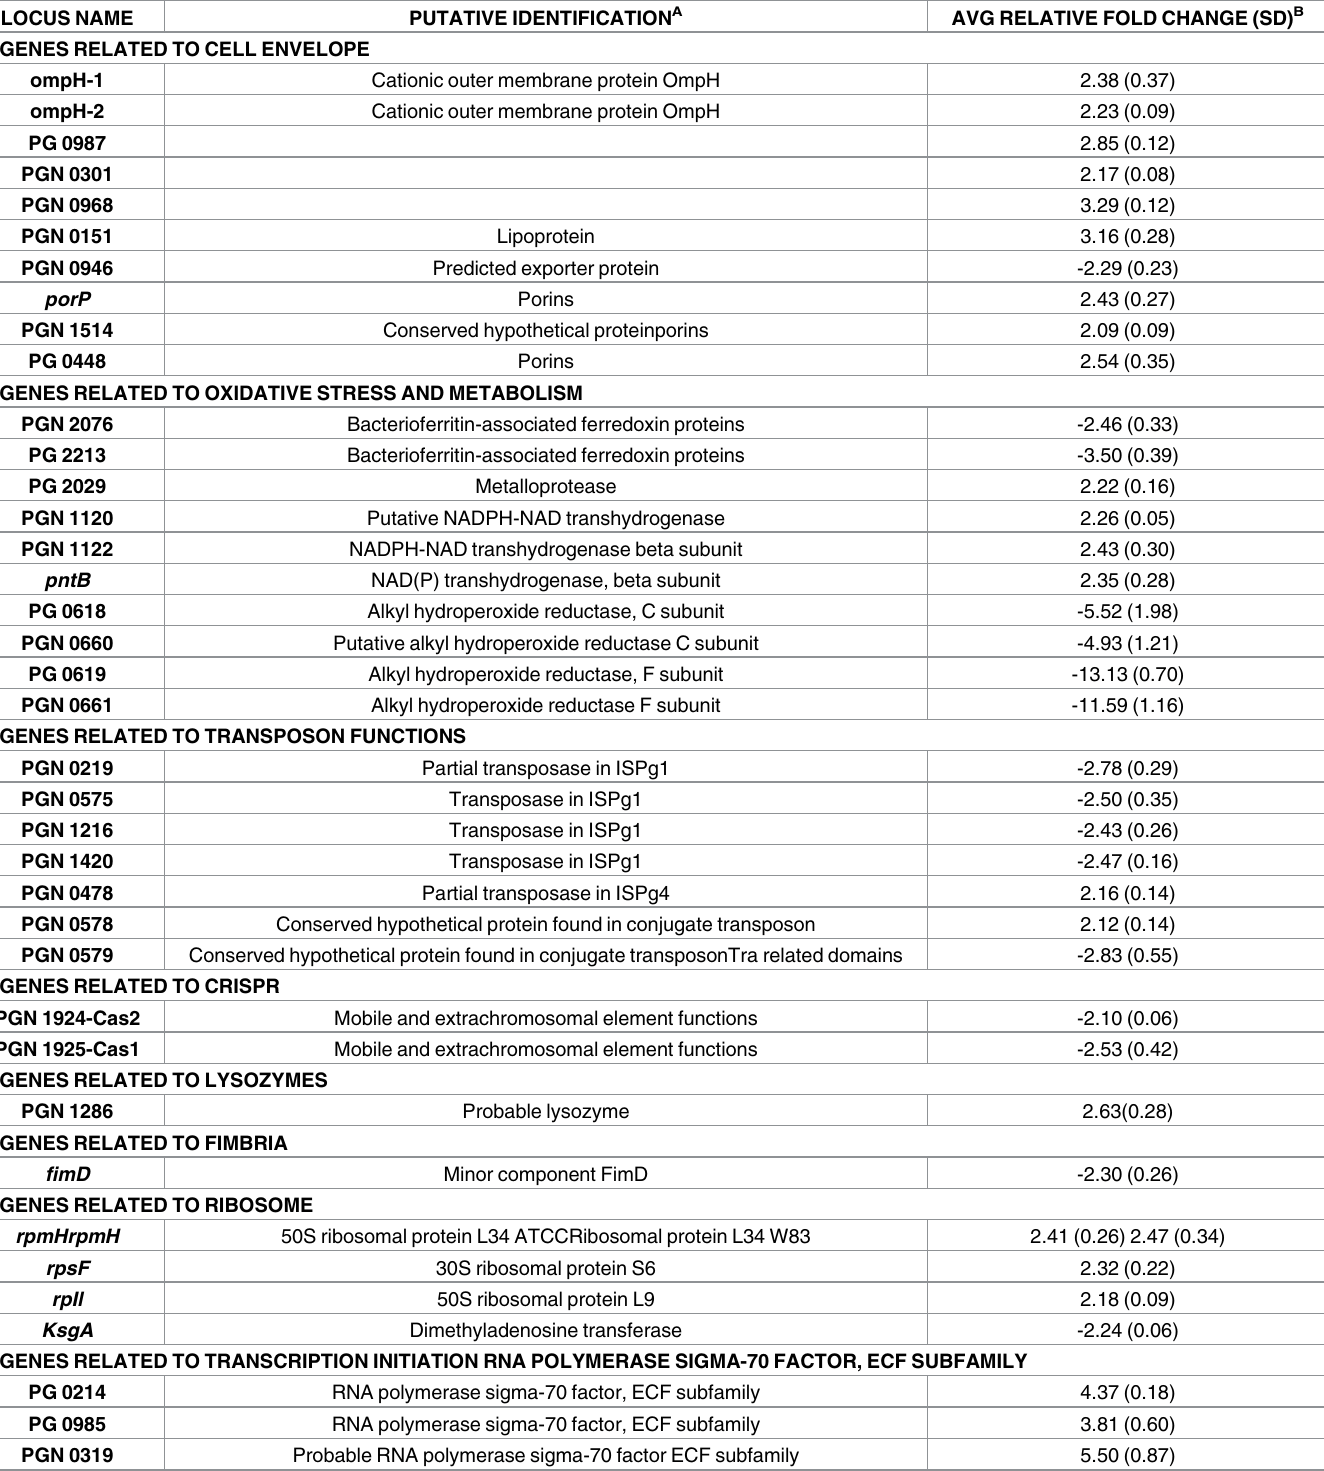
Table 2. Genes differently expressedin Porphyromonas gingivalis ATCC 33277 biofilm (cutoff ratio (cid:21) ± 2.0 fold change, p-value < 0.05) for the microarrayanalysis, grouped by functional role